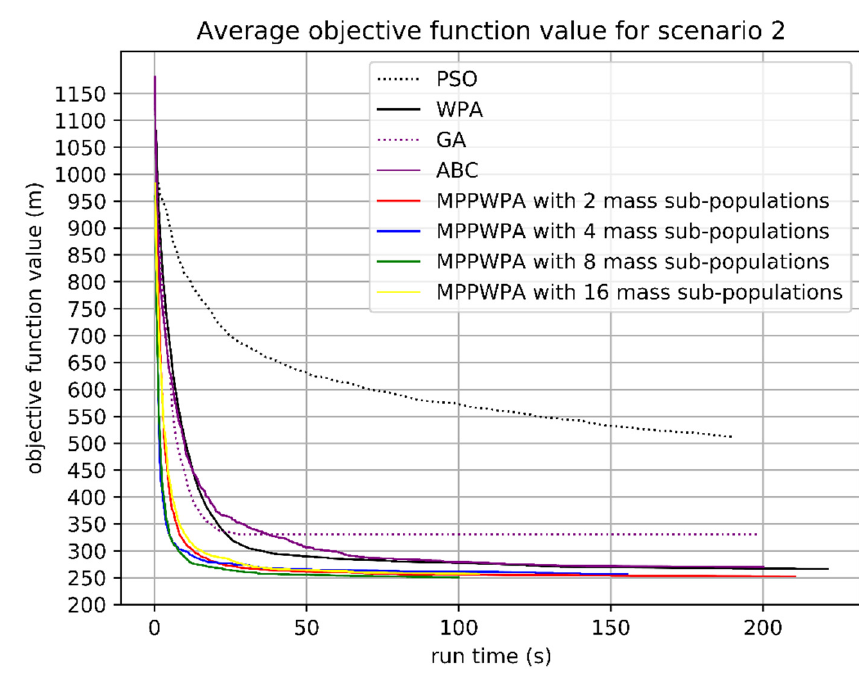
Figure 18. Average objective function values with different 𝑁𝑢𝑚 in scenario 2.